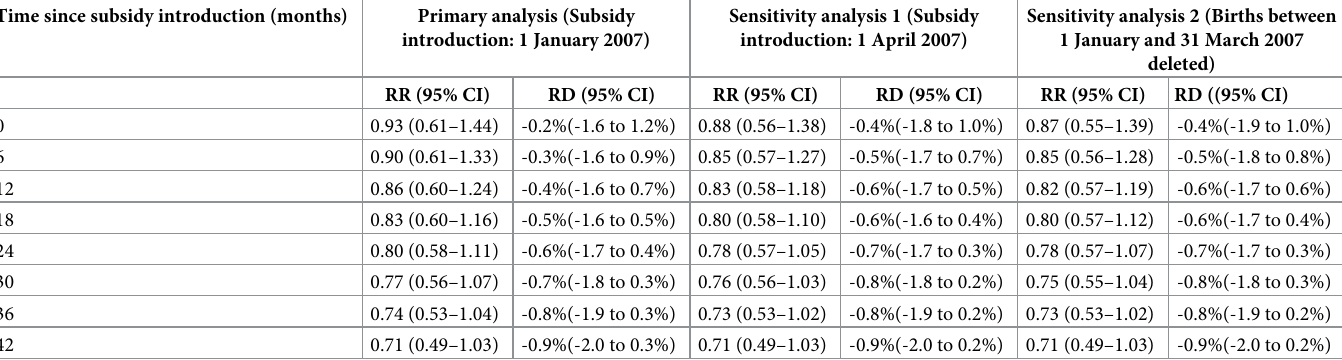
Table 6. Rate ratios (RRs) and Rate differences (RDs) with corresponding 95% Confidence intervals (CIs) for associations between subsidy introduction and neona- tal mortality over time in Burkina Faso. Time since subsidy introduction